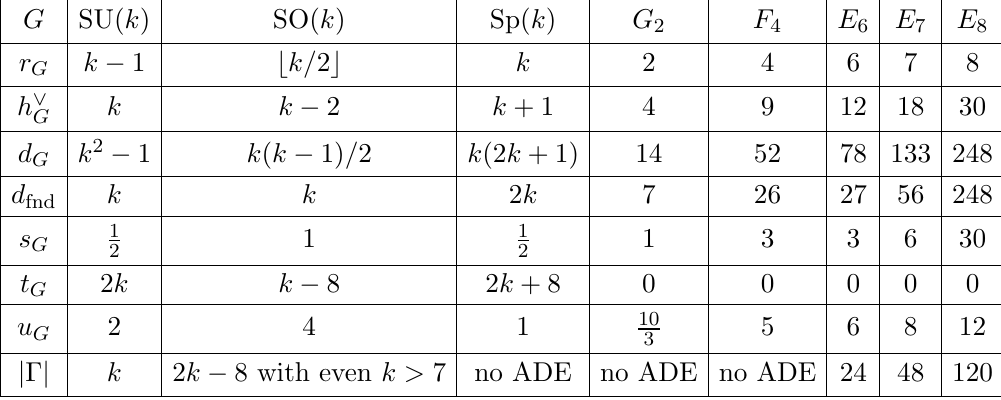
Table 2 . Group theory constants de(cid:12)ned for all G